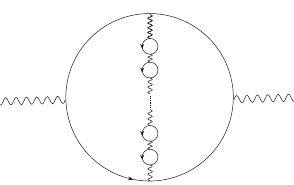
Figure 1 . An example of loop diagram contributions to the large- N F expansion of the gauge boson vacuum polarization at order 1 =N F . Each bubble produces a term proportional to K (cid:24) (cid:11) 1 N F .